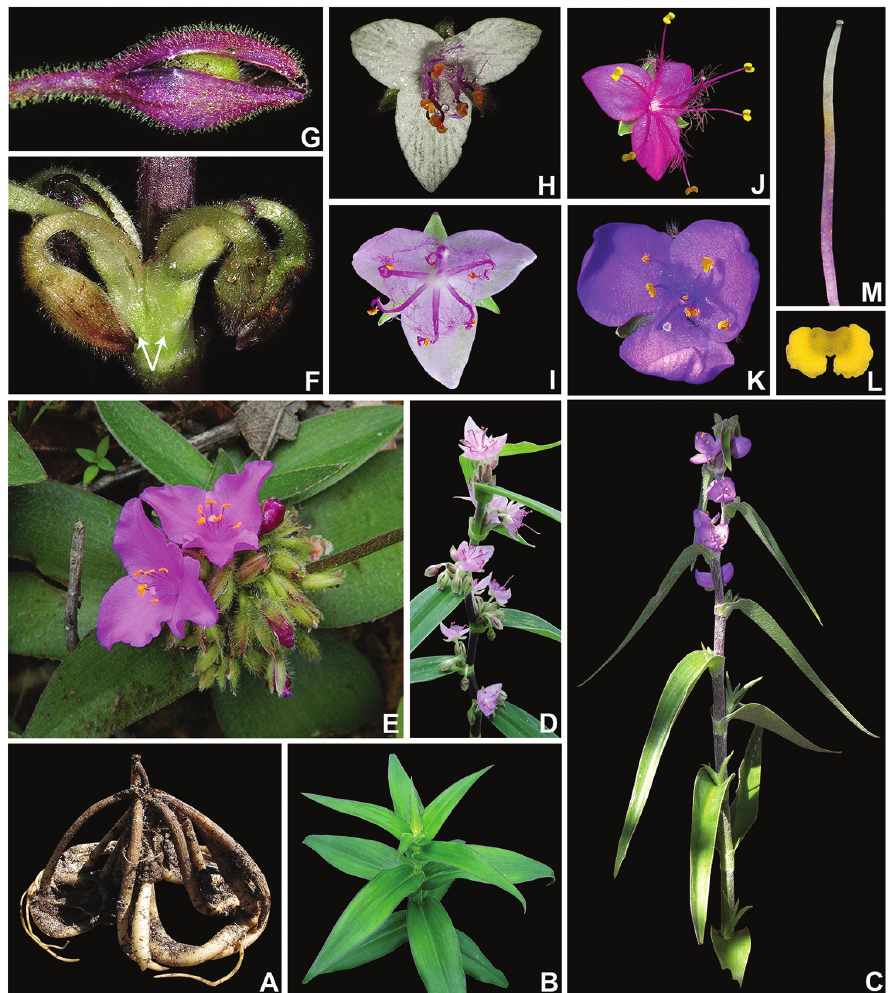
Figure 12. Tradescantia subg. Mandonia (D.R.Hunt) M.Pell. A thick tuberous roots on T. boliviana (Hassk.) J.R.Grant. B–E habit: B vegetative shoot of T. ambigua Mart. ex Schult. & Schult.f., showing the spirally-alternate leaves C flowering shoot of T. crassifolia Cav., showing the sessile and axillary inflores- cences restricted to the apex of the branch D flowering shoot of T. ambigua Mart. ex Schult. & Schult.f., showing the sessile and axillary inflorescences evenly distributed along the stem E rosette habit of T. iri- descens Lindl., showing the inflorescences restricted to the apex of the stem or in lateral shoots F detail of an inflorescence of T. ambigua , with arrows indicating the reduced cincinni bracts G post-anthesis flower of T. boliviana , showing glandular-pubescent sepals and hispid immature capsule H–K flowers: H flower of T. ambigua at anthesis I flower of T. ambigua at post-anthesis, showing the spirally-coiled filaments J flower of T. boliviana at anthesis, showing the peculiarly long filaments and style; K flower of T. crassioflia at anthesis, showing the campanulate perianth L anther of T. ambigua , showing the C-shaped anther sacs and quadrangular and slightly curved connective M style of T. ambigua , showing the capitulate stigma. A, J by P. Christian (RarePlants.co.uk), B by E.O. Moura, C, K by T.R. Van Devender, D, I by L.J. Leitão, E by J.C. Garcia Morales, F, H, L–M by M.O.O. Pellegrini, and G by Instituto